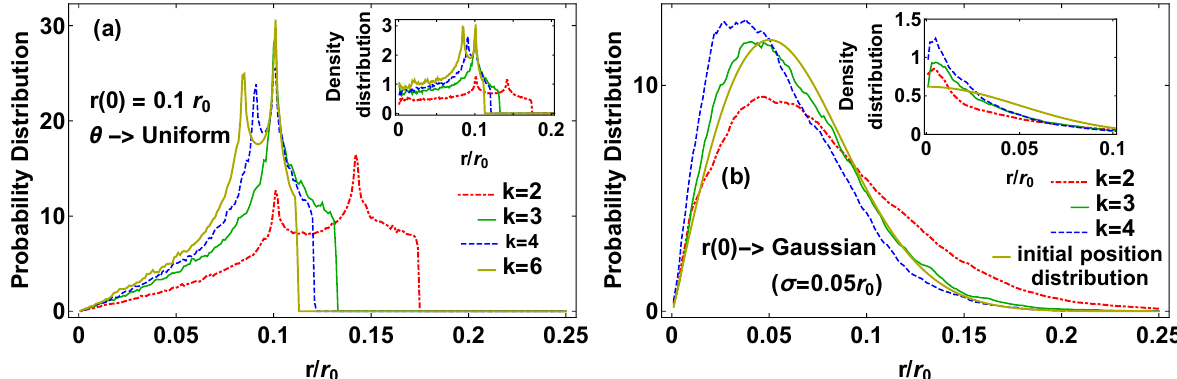
Figure 5. Panel ( a ) shows the probability distribution for an ion created at radial distance of 0.1 r 0 , with random angular coordinate θ for various 2 k -pole traps. Panel ( b ) shows the probability distribution for an ion created with a Gaussian distribution of width 0.05 r 0 , centered with the ion trap for various 2 k -pole traps. The insets show the corresponding density